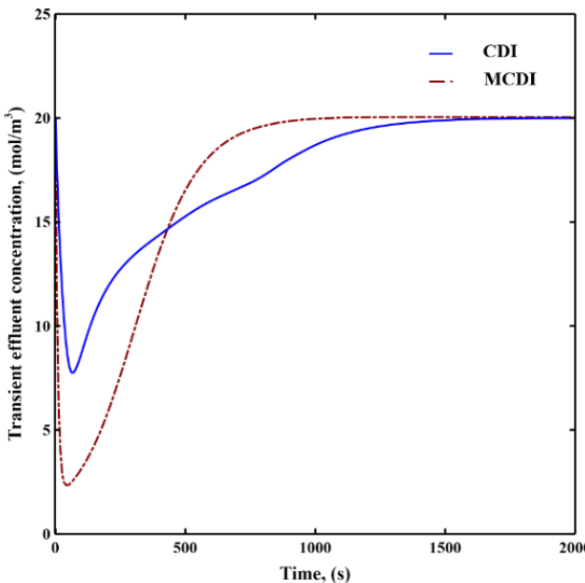
Figure 4. Transient e ffl uent concentration curves of CDI and MCDI. The applied voltage is 0.8 V, the flow rate is 10 mL / min, and the feed water concentration is 20 mol / m 3 . The ion flux distributions of sodium ions and chloride ions along a cross-sectional line of CDI and MCDI at t = 50 s under the same operating conditions of a flow rate of 10 mL / min, an applied voltage of 0.8 V, and a feed water concentration of 20 mol / m 3 are displayed in Figure 5a,b, respectively. The time of 50 s was chosen because it is near the minimum e ffl uent concentration and the maximum changes in concentration profile across both cells, making sure the absolute values of ion fluxes are large enough to show a clear deviation between CDI and